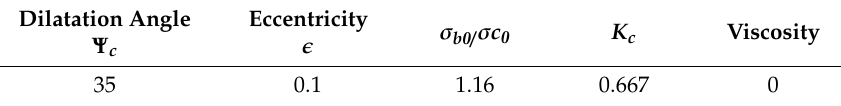
Table 3. The CDP model parameters for AAC and mortar. [43].